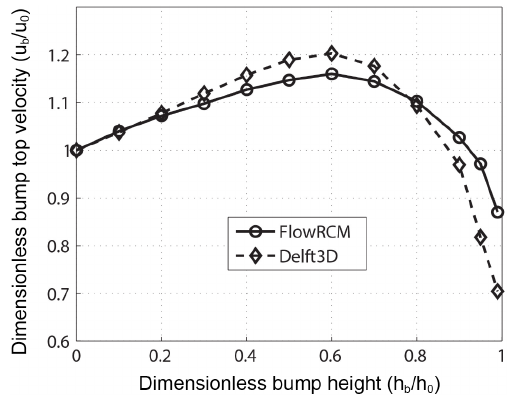
Figure 6. Comparison of dimensionless bump top velocity ( u b /u 0 ) as a function of dimensionless bump height ( h b /h 0 ) predicted by FlowRCM and Delft3D. Both models predict an initially rising and then falling flow velocity as the dimensionless bump height goes to 1. FlowRCM also captures the turning point where rising changes to falling ( ∼ 60% flow depth). Flow velocity is scaled by the normal flow velocity magnitude, and bump height by normal flow depth.